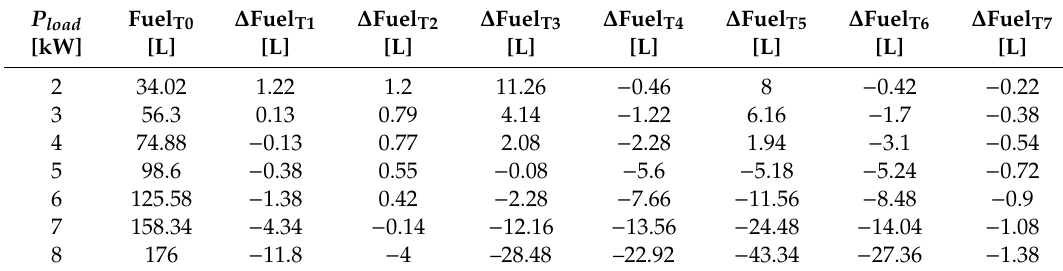
Table 2. Fuel economy for k fuel = 0 and di ff erent P load .